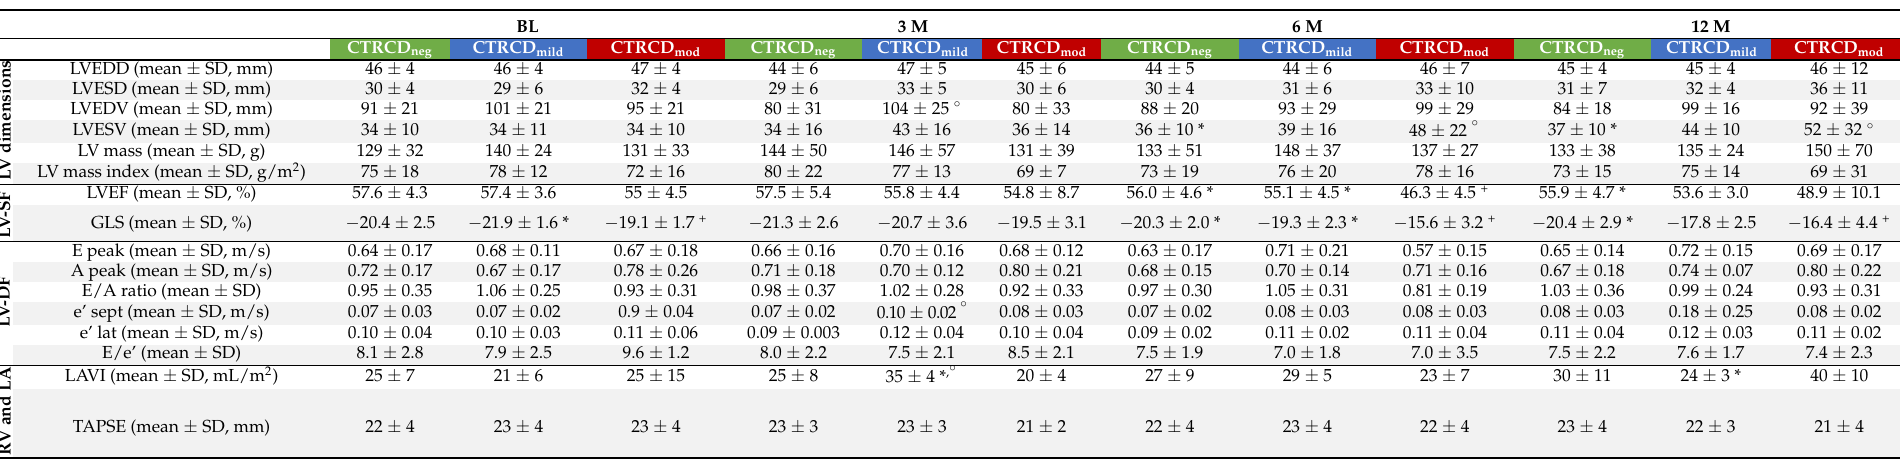
* vs. CTRCD mod ; ◦ vs. CTRCD neg ; + vs. CTRCD neg+mild ; p ≤ 0.05.